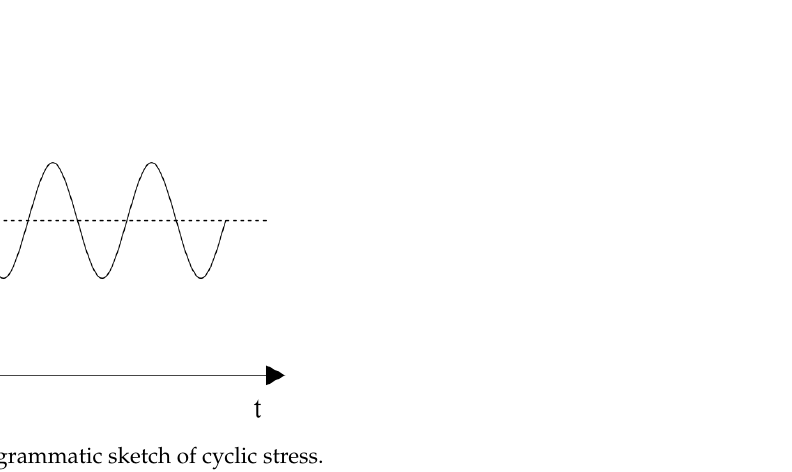
Figure 1. Diagrammatic sketch of cyclic stress.